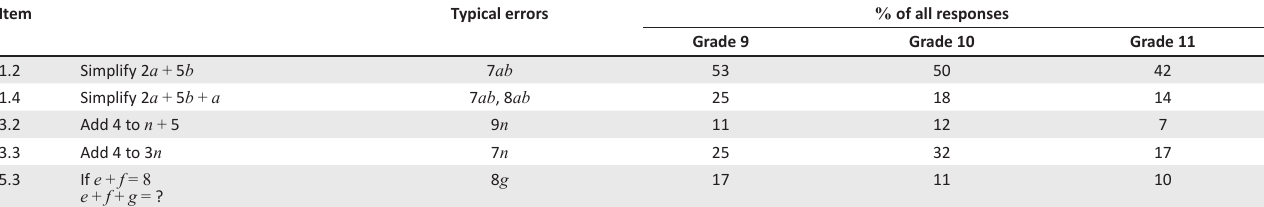
TABLE 2: Percentage of responses showing conjoining